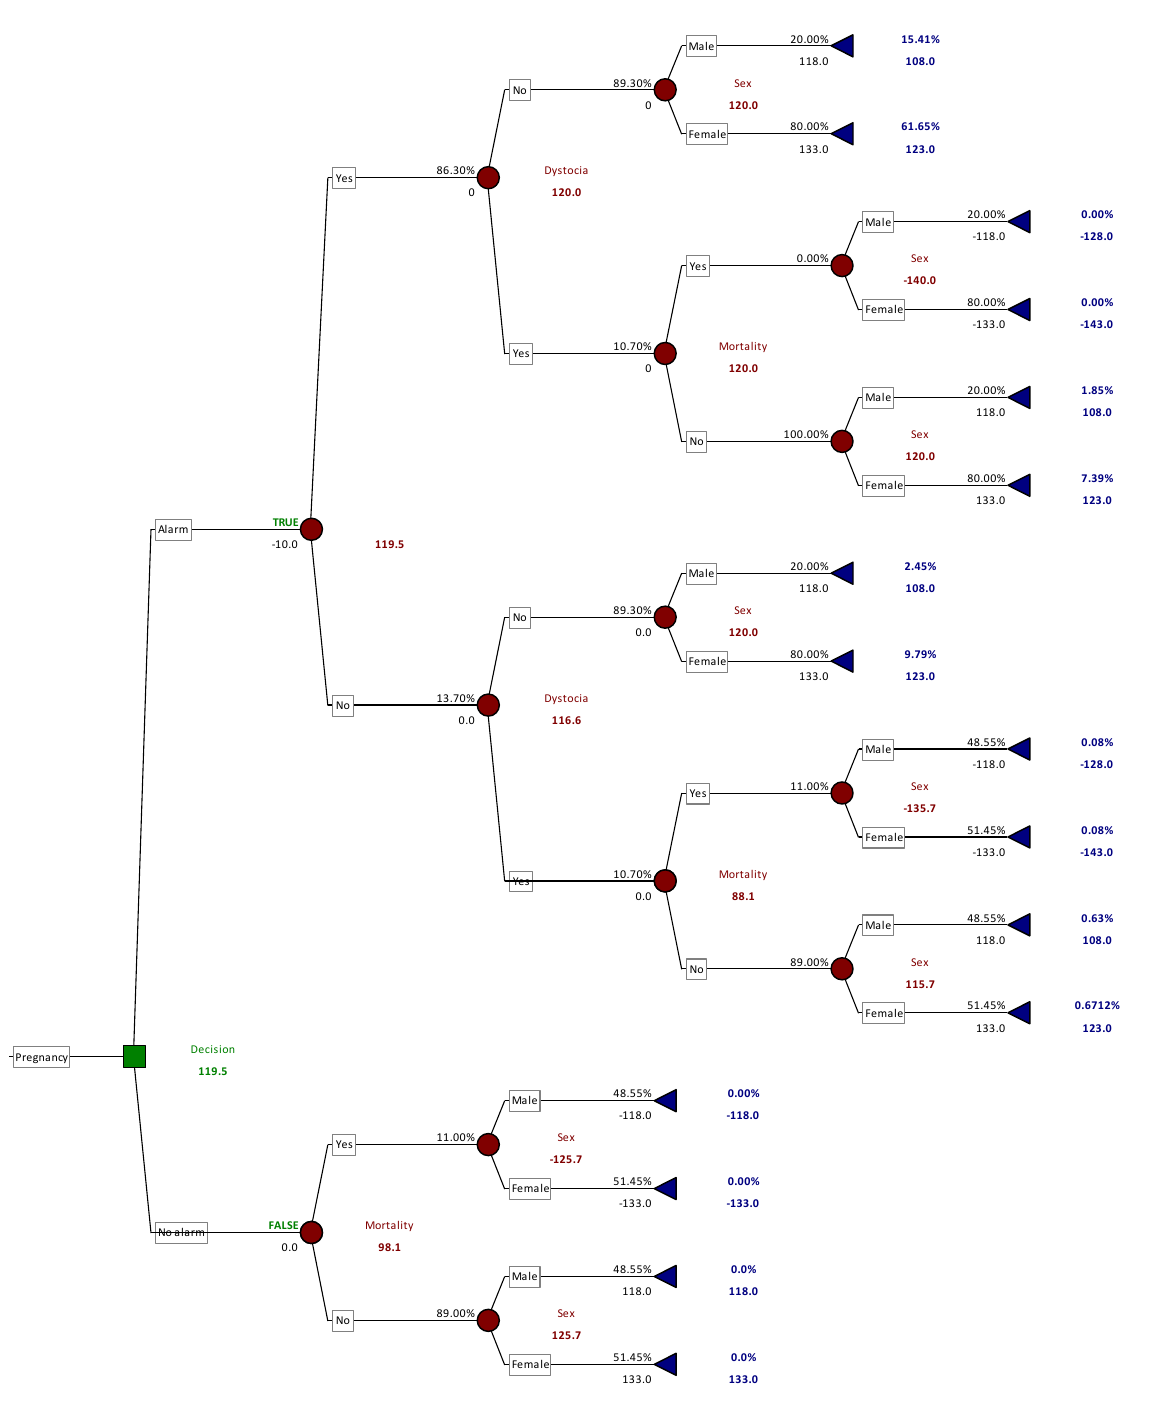
Figure 6. Decision-tree for the application of the calving sensor in primiparous cows. Green square identifies the decision to apply the sensor. Red dots represent the binary options, such as alarm sensitivity and dystocia outcome, based on data reported in Table 1. Black numbers on branches represent the probability of each chance (number over the branch), while the number below the branch represent the monetary value of the outcome (EUR). Red numbers within branches represent the monetary value of the combined outcome (EUR). Blue numbers at the end of the branches represent the probability and monetary value (EUR) of the whole branch.